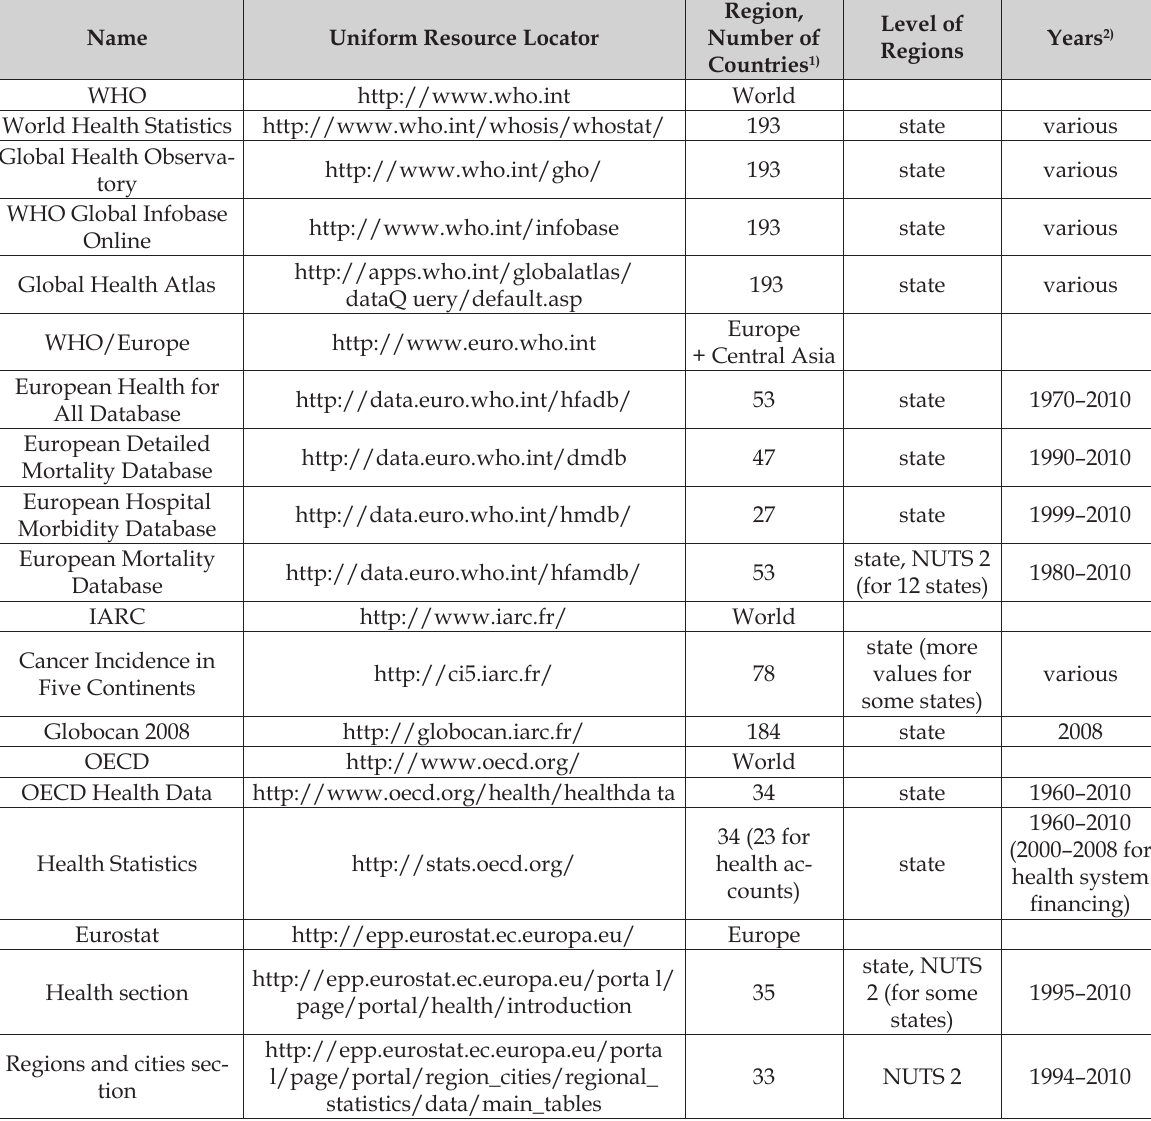
Table 1. Basic information about selected international health data sources. Situation in December